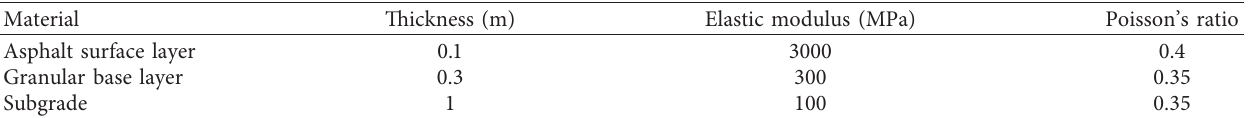
Table 1: Pavement material